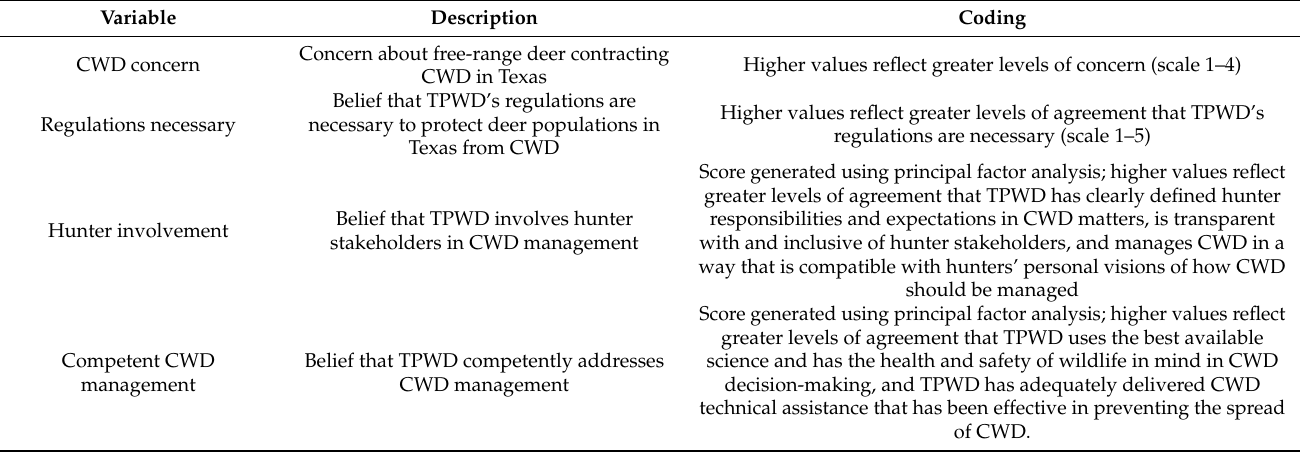
Table 2. Description of variables included in the latent profile analysis of Texas